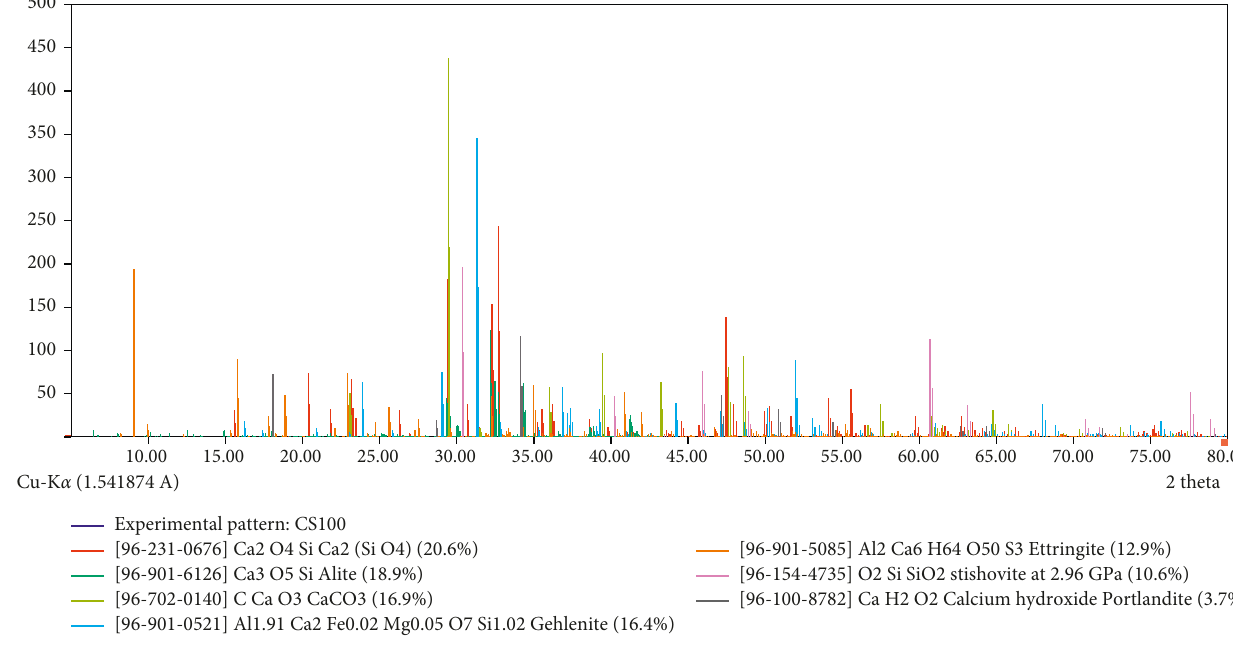
Figure 13: X-ray diffractogram of the mix CS100 at 28 days.